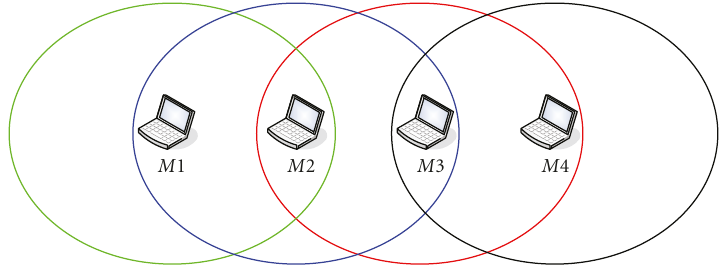
Figure 9: Hidden and exposed terminals